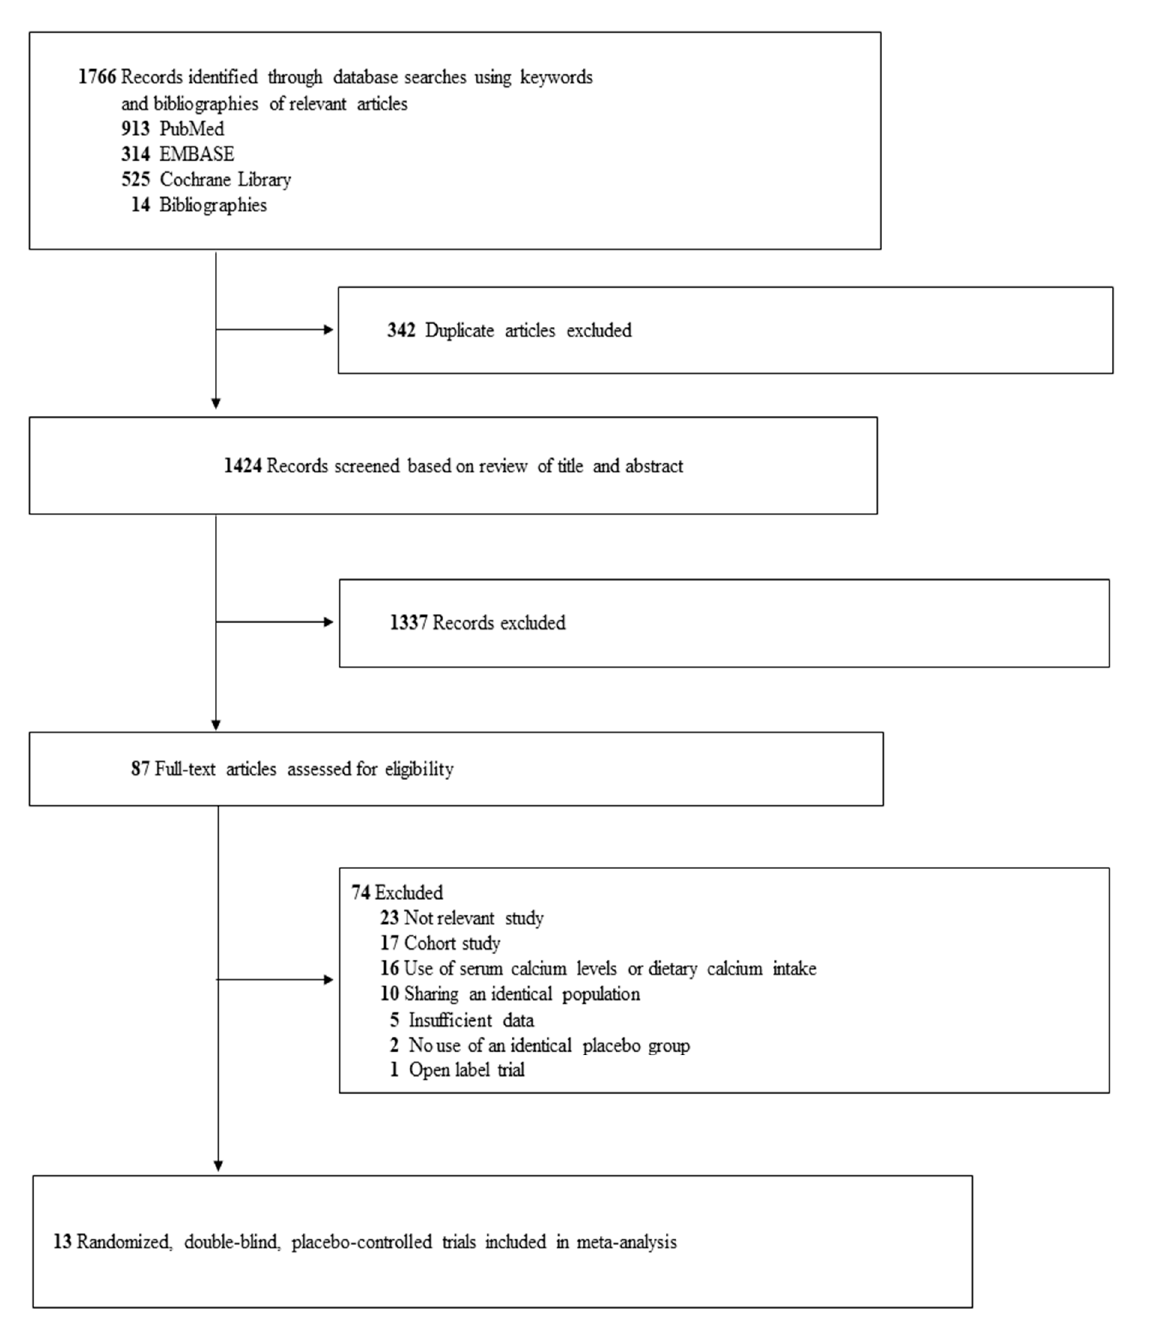
Figure 1. Study selection.